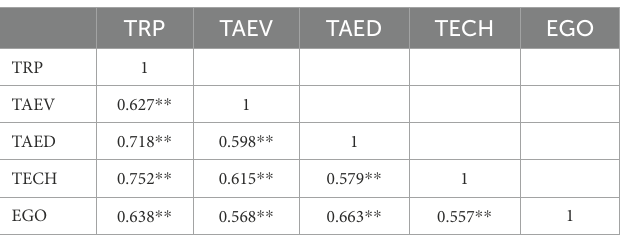
TABLE 2 Correlation matrix results.